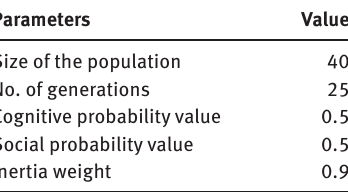
Table 3: DPSO Parameters.